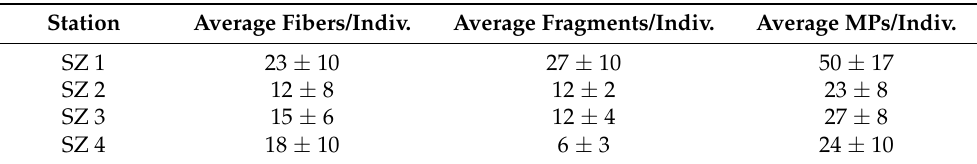
Table 1. Stations and mean ± standard deviation of all the microplastic relative data with respective